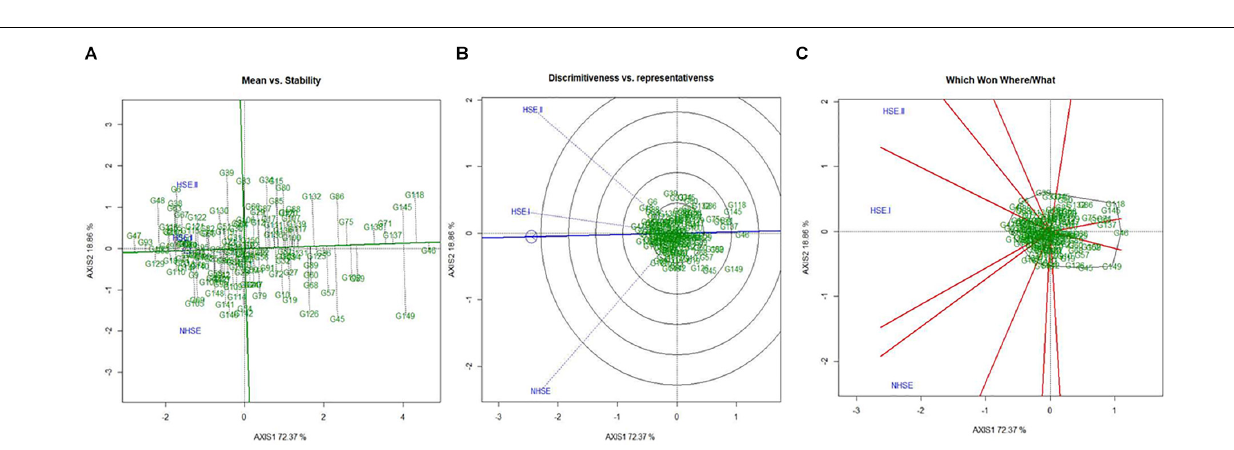
FIGURE 7 | GGE biplots developed by plotting the first and second principal components derived from the germination value of all the genotypes of field pea evaluated in three environments (NHSE, HSE-I, and HSE-II). (A) “Mean versus Stability” view of genotypes. (B) Discriminating ability and representativeness of three environments, (C) which won where/what of field pea genotypes under different